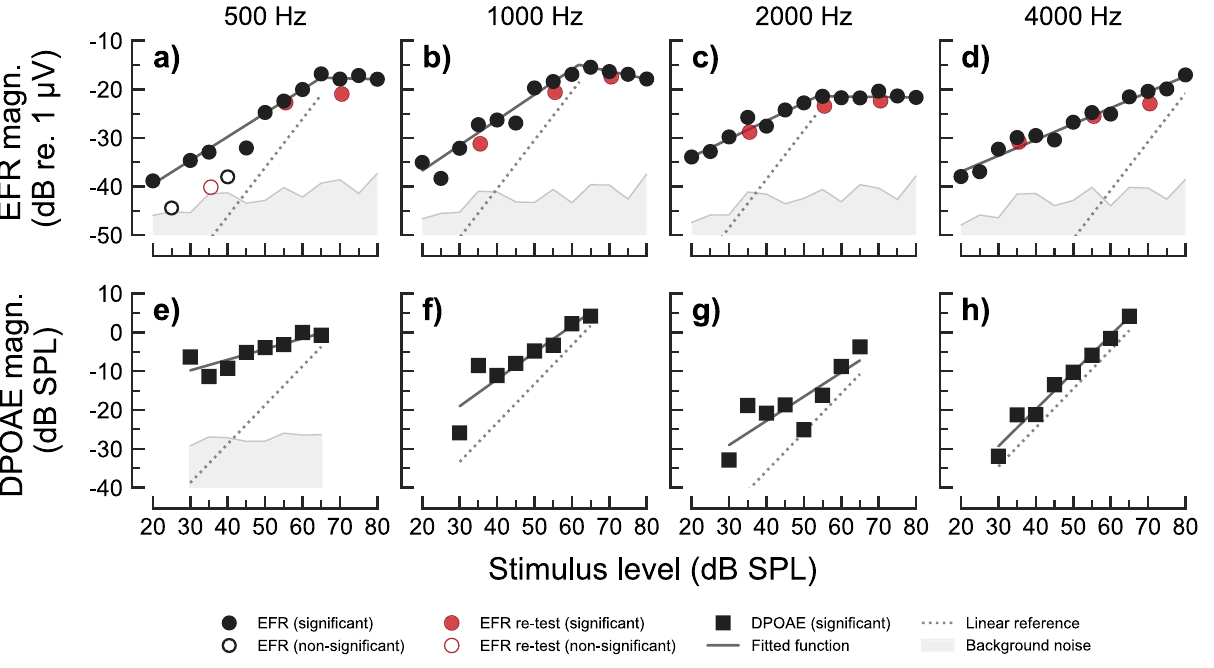
Figure 1. EFR (panels a – d ) and DPOAE (panels e – h ) magnitude-level functions recorded in one representative NH listener (NH01) for the frequencies of 500 Hz (panels a , e ), 1000 Hz (panels b , f ), 2000 Hz (panels c and g) and 4000 Hz (panels d , h ). EFR and DPOAE magnitudes are represented as filled circles and squares, respectively, in case of statistically significant responses. Open symbols show statistically non-significant data points. Grey shaded areas show the estimated background noise. In panels ( a – d ), black circles indicate EFR magnitudes recorded in the first recording session, and red circles indicate retest EFR magnitudes recorded in the second recording session. Fitted models to significant data points are represented by the solid dark-grey functions. A linear reference with a slope of 1 dB/dB is indicated by the dotted